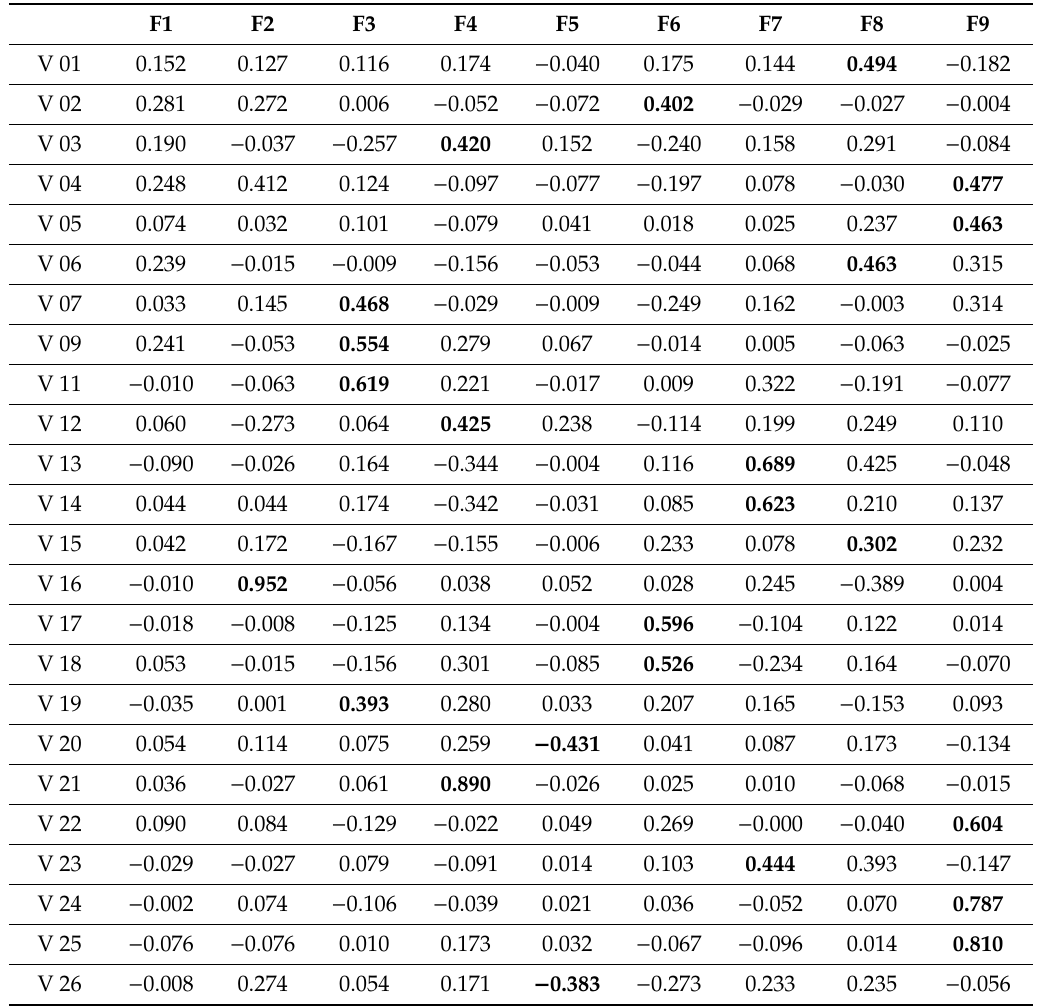
Table 3. Rotated factor